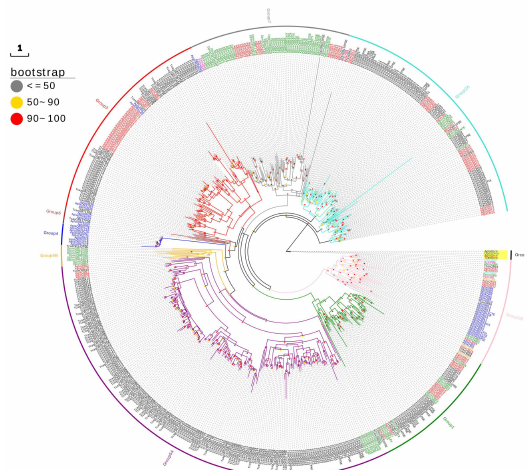
Figure 1. ORs of Anoplophora glabripennis (red), Tribolium castaneum (black), Dendroctonus ponderosae (green), Agrilus planipennis (blue), Megaxylene Caryae (orange), Ips typographus (pink), Hylobius abietis (Turquoise), and Rhynchophorus ferrugineus (purple) phylogenetic analysis. A phylogenetic tree was constructed according to the maximum likelihood method using PhyML (node support based on 1000 bootstrap replications is shown). 2.3. AglaOR Gene and Protein Structure Comprehensive analysis of the conservative motif, conserved protein domain, and genetic structure of the AglaORs revealed differences in the motif structure between each subfamily (Figure 2). Details of the ten motifs are provided in the supplementary infor- mation. In Group I, motifs 1 and 6 were considered to be conserved motifs. Motifs 1 and 7 were unique motifs in Group II. Group III has motifs 1, 2, 3, 5, 6, and 10 as the conserved motif, AglaOR86 and AglaOR55 lacked motif 6, and AglaOR82 lacked motifs 2, 5, and 10. Group IV has motifs 1, 4, 6, and 7 as the conserved motif. The gene structure map of in- trons–exons showed that Group I mostly contains 3–7 introns, of which, AglaOR1 and AglaOR9 contain 10 and 9 introns, respectively. Most of Group II has 2–6 introns. Group III mostly contains 4–6 introns, except that of AglaOR82, which had two introns. Group IV mostly contains 4–6 introns.